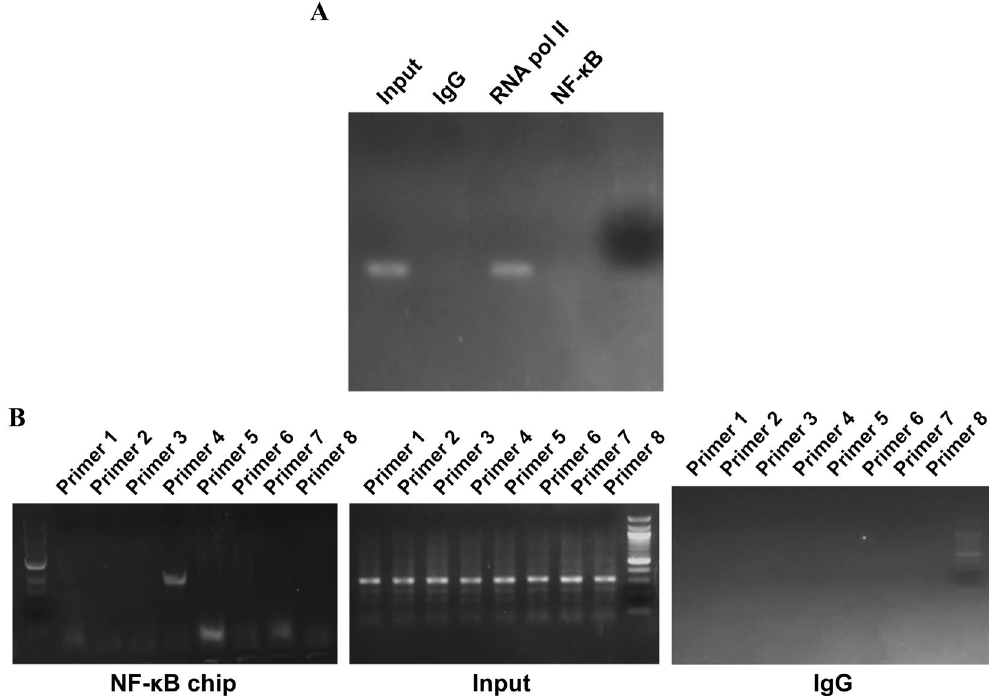
Figure 7. MyD88 up-regulates BDNF expression during S. pneumoniae meningitis by direct binding of NF- κ B to the BDNF promoter. ChIP experiments were carried out in the mouse BV-2 cell strain. Nuclear extracts were analyzed by ChIP-PCR. IgG and RNA pol II antibody was used as negative and positive control. ( A ) GAPDH prime sets were performed to examine the validity. ( B ) One pair of BDNF primes amplified the ChIP products in NF- κ B